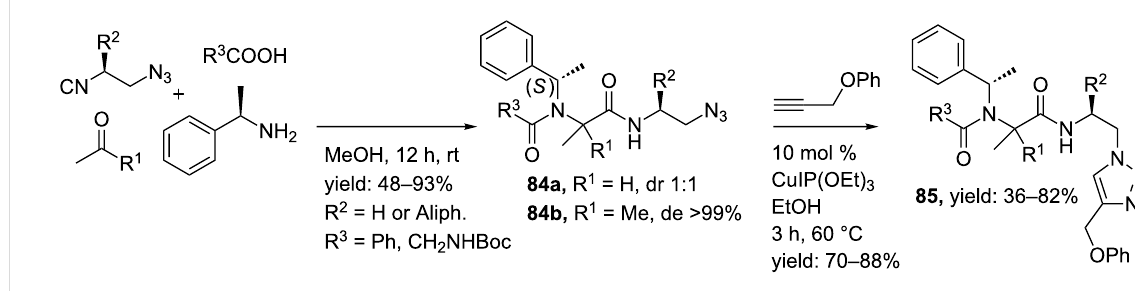
Scheme 26: The Ugi/Click sequence provided triazole based peptidomimetics.